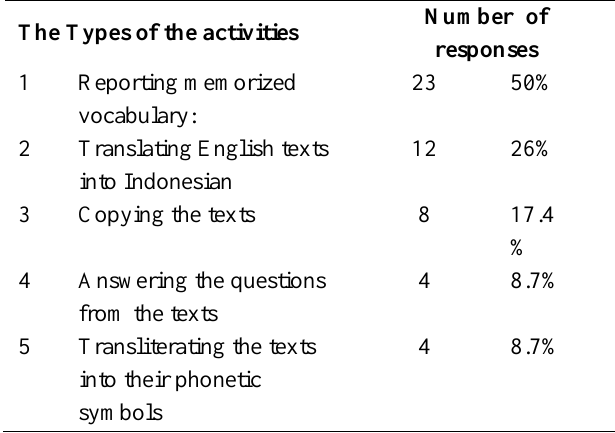
TABLE 2 | Type of activities mostly perceived